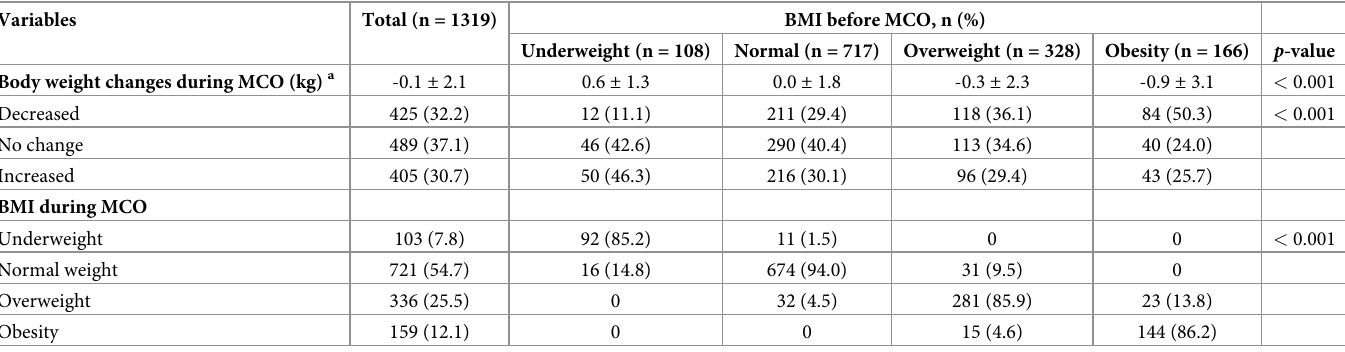
Table 2. Changes of body weight and BMI category during